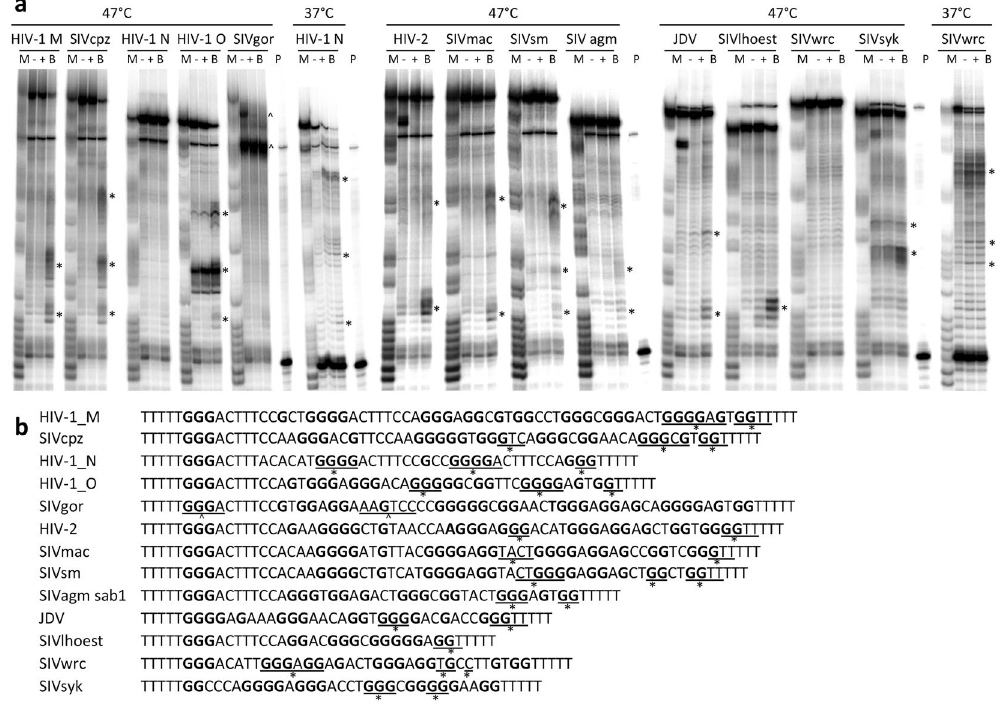
Figure 4. Taq polymerase stop assay of lentiviral G4 sequences. Oligonucleotides bearing PQSs were folded in the absence ( − ) or presence ( + ) of KCl. KCl-treated samples were further incubated with the G4 ligand BRACO-19 (B). Oligonucleotides were used as templates in a Taq polymerase reaction at 47 °C or 37 °C as indicated. Symbols * indicate premature stop site at G bases in gel images ( a ) and in the corresponding G4 sequences ( b ). Symbols ^ indicate stop sites independent of G4 folding. G-bases are shown in